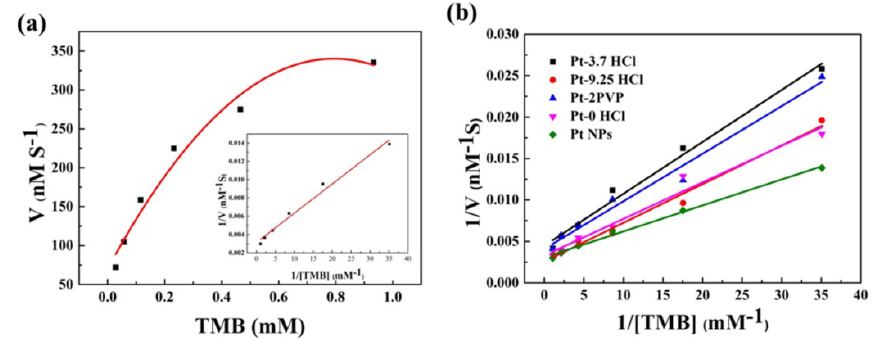
Figure 5. ( a ) Michaelis–Menten curve of Pt NPs with TMB, Inset: Lineweaver–Burk plots of Pt NPs with TMB; ( b ) Lineweaver–Burk plots of different Pt nanoparticles.